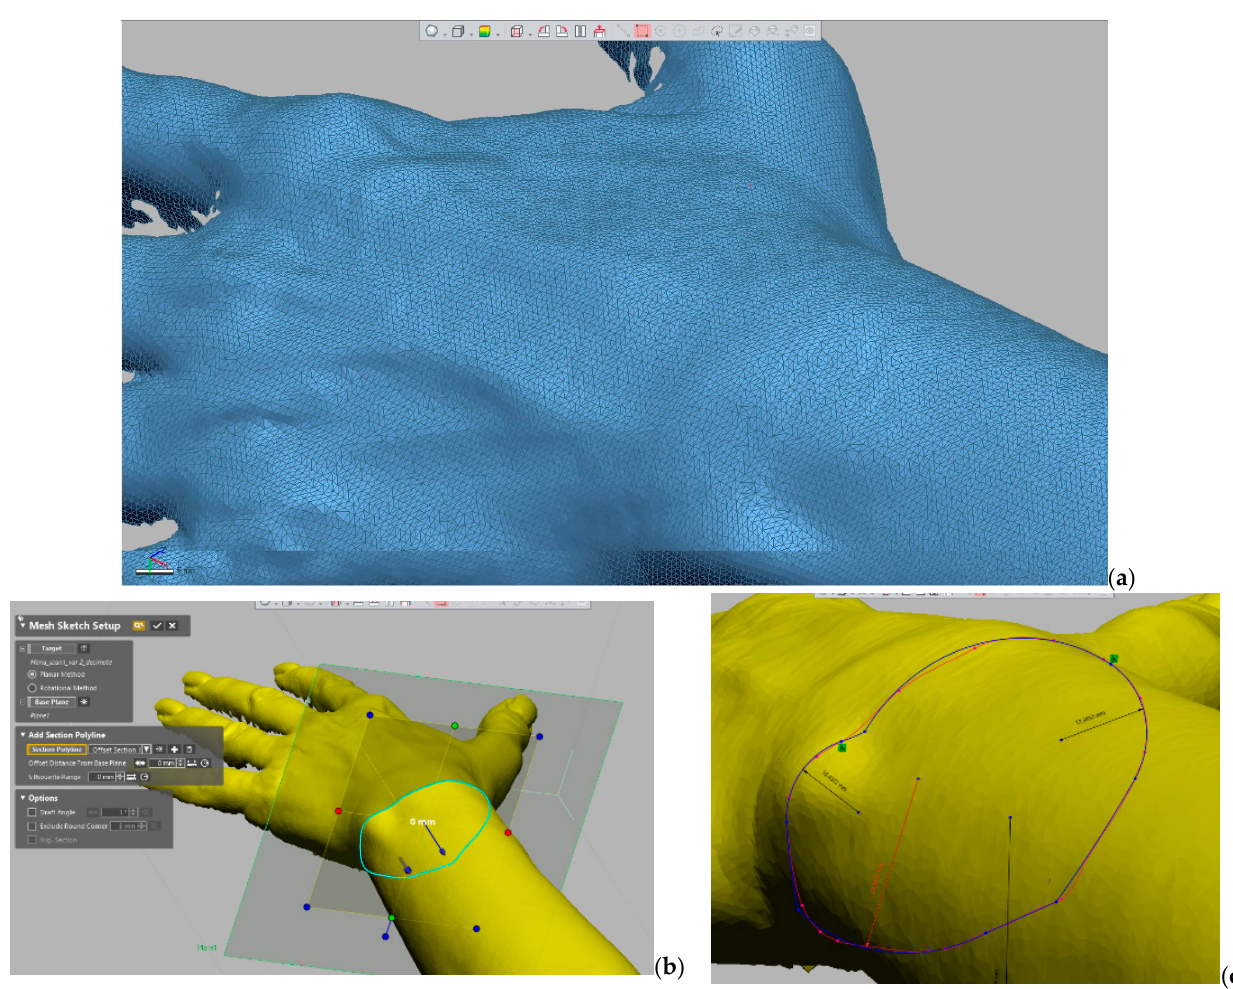
Figure 5. Reverse engineered real upper limb surface—horizontal plane contour characteristics: ( a ) triangle mesh, ( b ) di- mensions obtained, ( c ) parametrization.